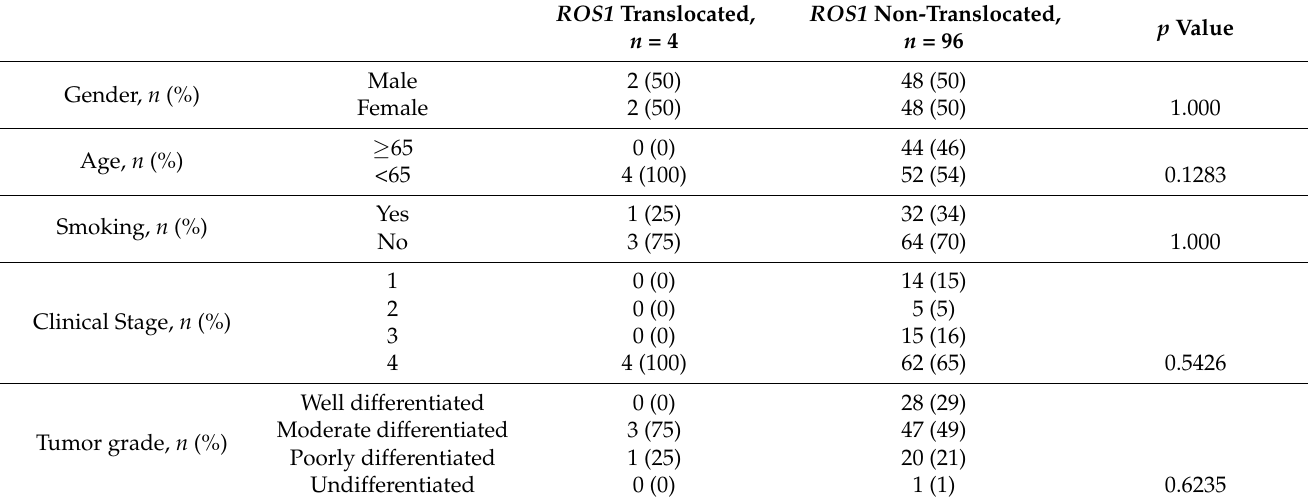
Table 1. Characteristics of ROS1 translocated and non-translocated groups in pre-crizotinib period. ROS1